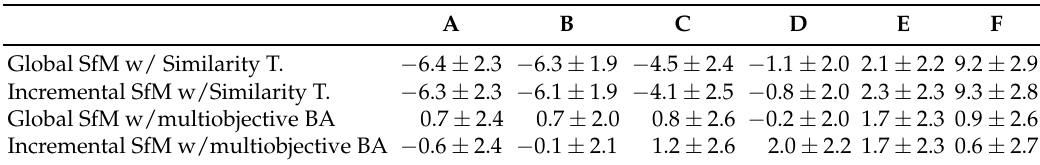
Table 6. Estimated scale errors (%) per segment for different reconstructions of AUTT28 area (values represent mean value with standard deviation). A B C D E F Global SfM w/ Similarity T.